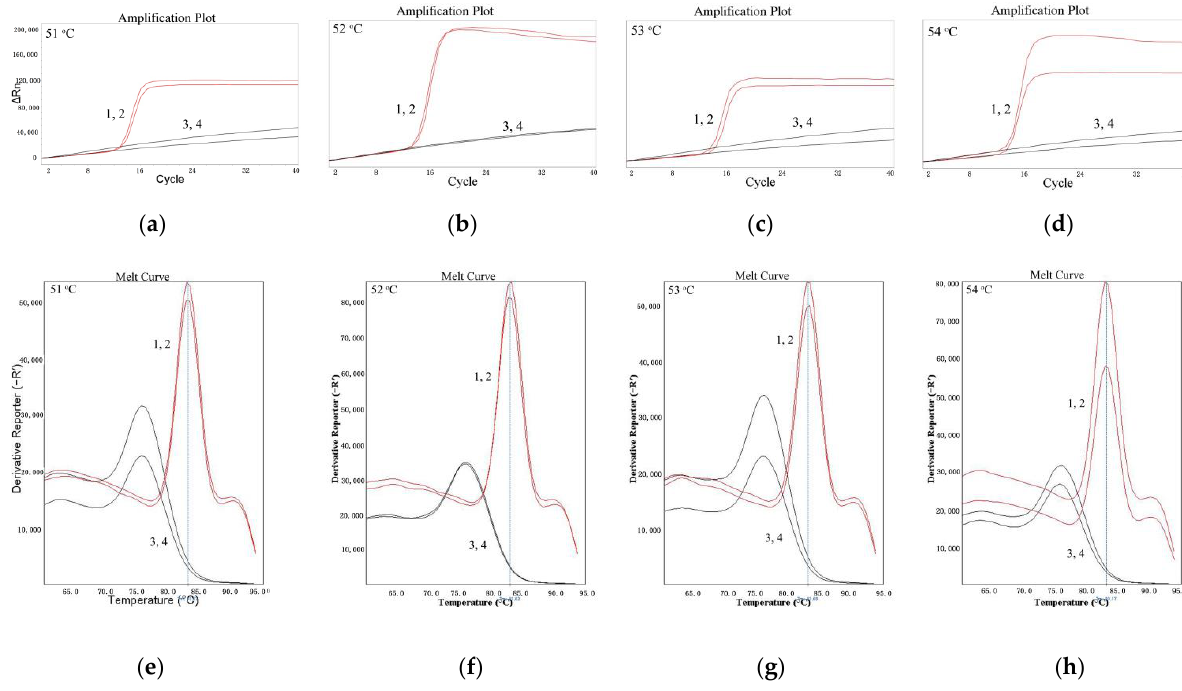
Figure 1. Amplification plot and melt curve of the LMTIA reaction at different temperatures. ( a ): the amplification plot of the LMTIA reaction at 51 ◦ C; ( b ): the amplification plot of the LMTIA reaction at 52 ◦ C; ( c ) the amplification plot of the LMTIA reaction at 53 ◦ C; ( d ): the amplification plot of the LMTIA reaction at 54 ◦ C; ( e ): the melt curve of the LMTIA reaction at 51 ◦ C; ( f ): the melt curve of the LMTIA reaction at 52 ◦ C; ( g ): the melt curve of the LMTIA reaction at 53 ◦ C; ( h ): the melt curve of the LMTIA reaction at 54 ◦ C. 1, 2: cassava ( M. esculenta ) DNA; 3, 4: ddH 2 O.